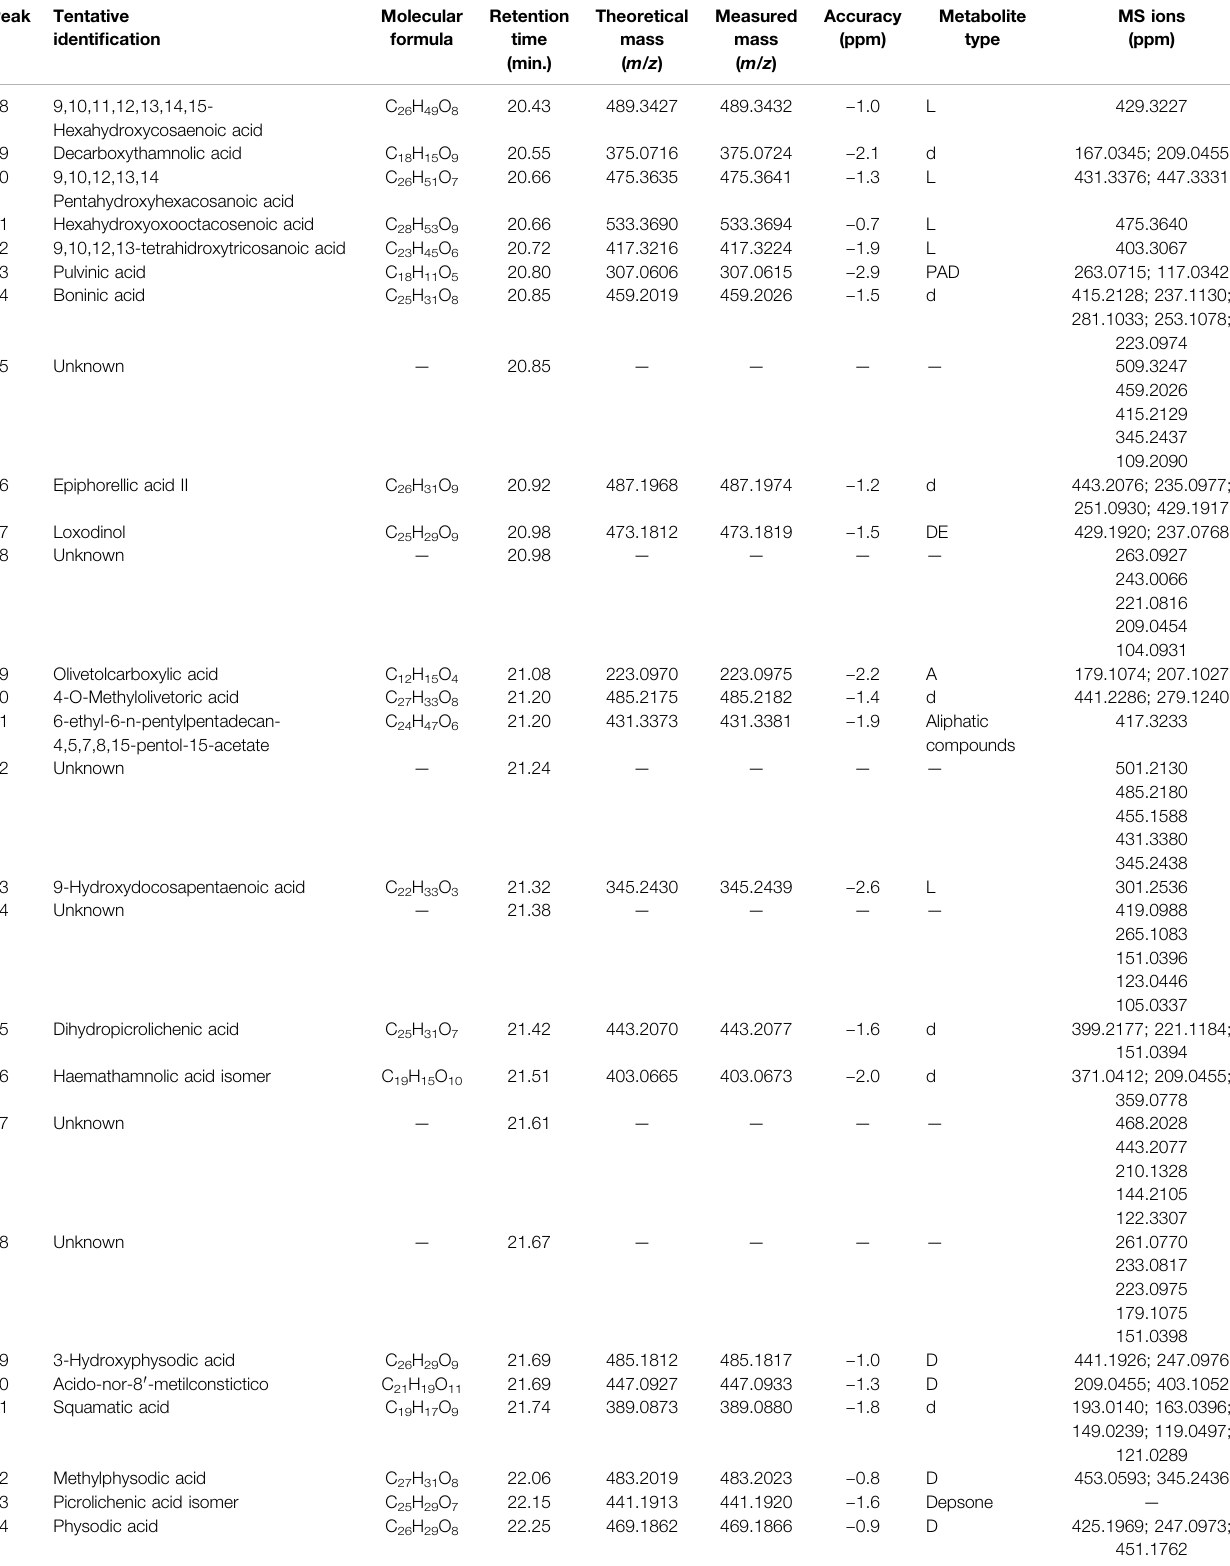
TABLE 3 | ( Continued ) Biochemical composition of 70% methanol extract by UHPLC-DAD-MS analysis the negative ion mode. Peak Tentative identi fi